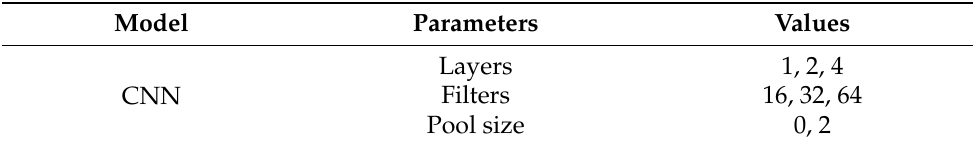
Table 3. Grid of parameters used for CNN models.